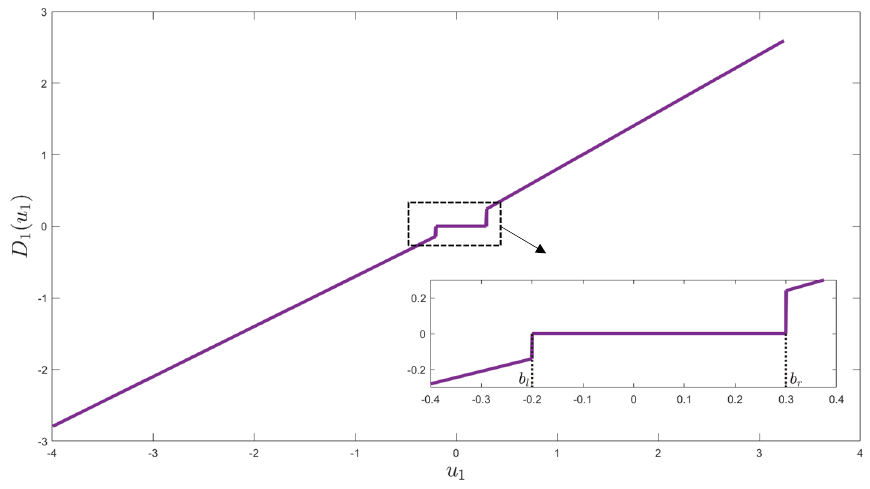
u with dead zone and the control input. 1